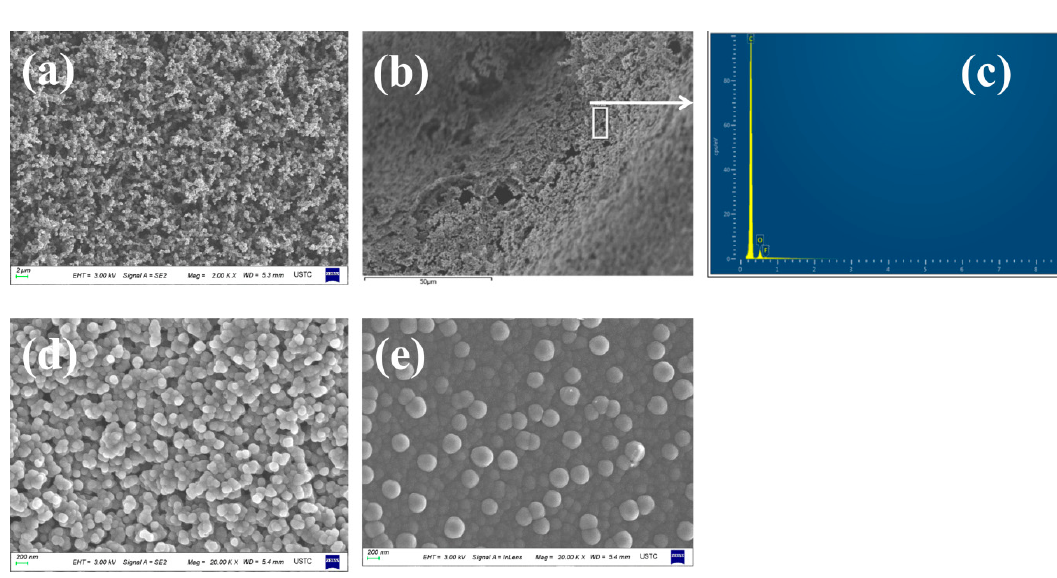
Figure 5. GC–MS results of oily liquids collected from the inner wall of the quartz tube. ( a ): Gas chromatogram of oily liquids products; ( b ): Mass spectrum of Peak 1; ( c ): Mass spectrum of Peak 2; ( d ): Mass spectrum of Peak 3.